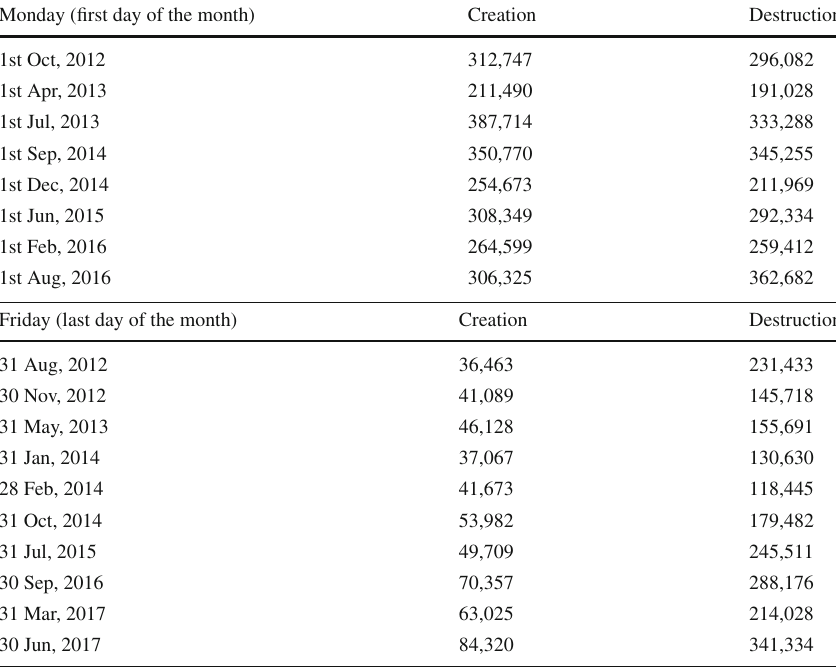
Table 8 Calendar effect for either the beginning or end of a month Monday (first day of the